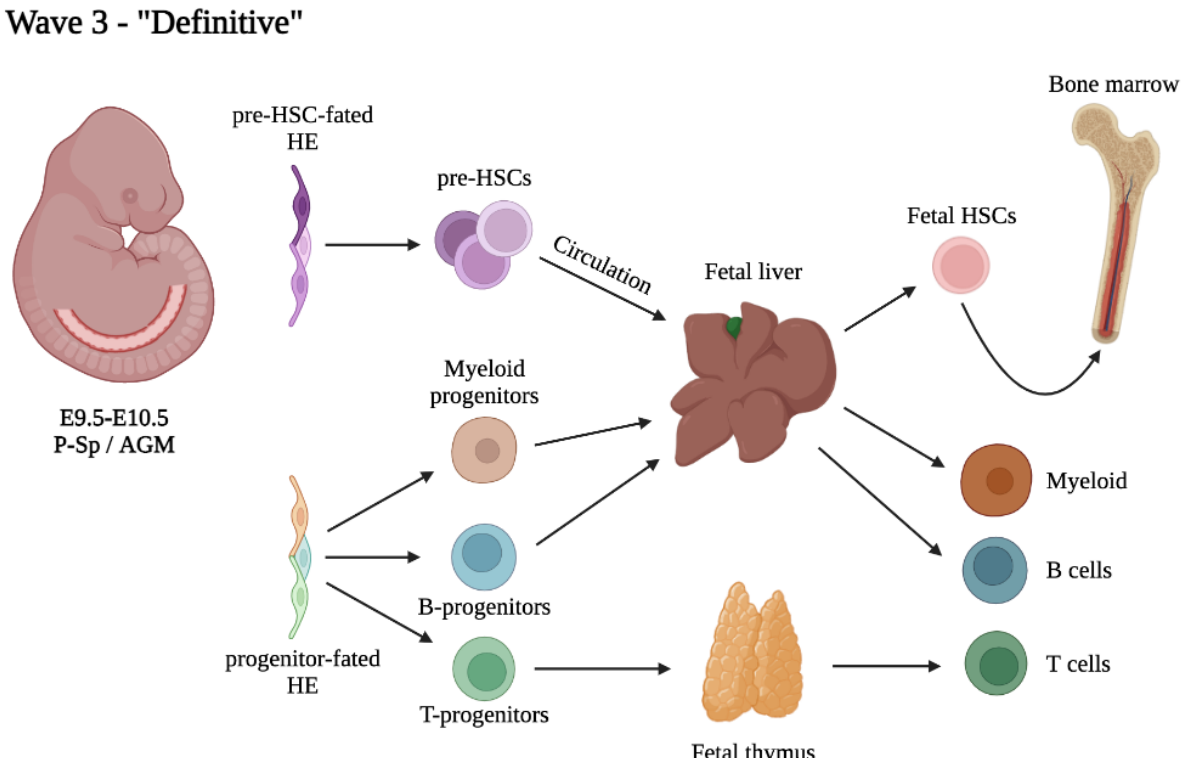
Figure 3. S uggested schematic of the intraembryonic or “definitive” hematopoietic